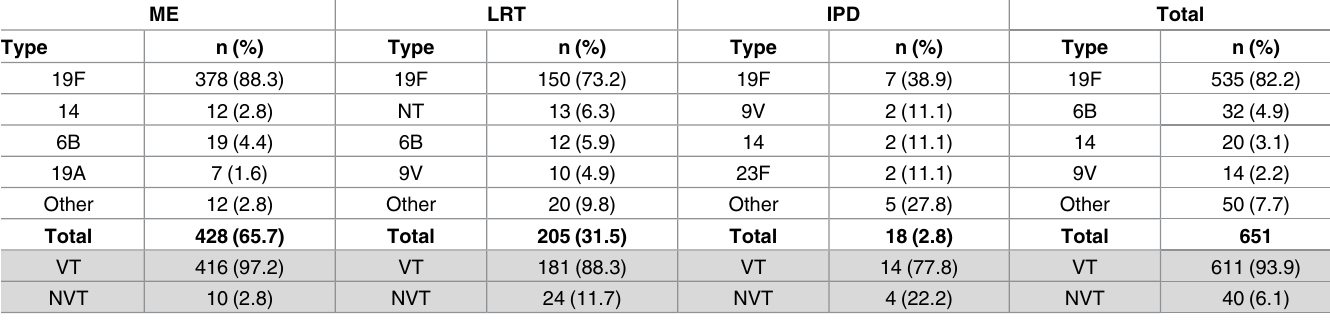
Table 3. Ranking of the 4 most common PNSP serotypesaccording to sampling